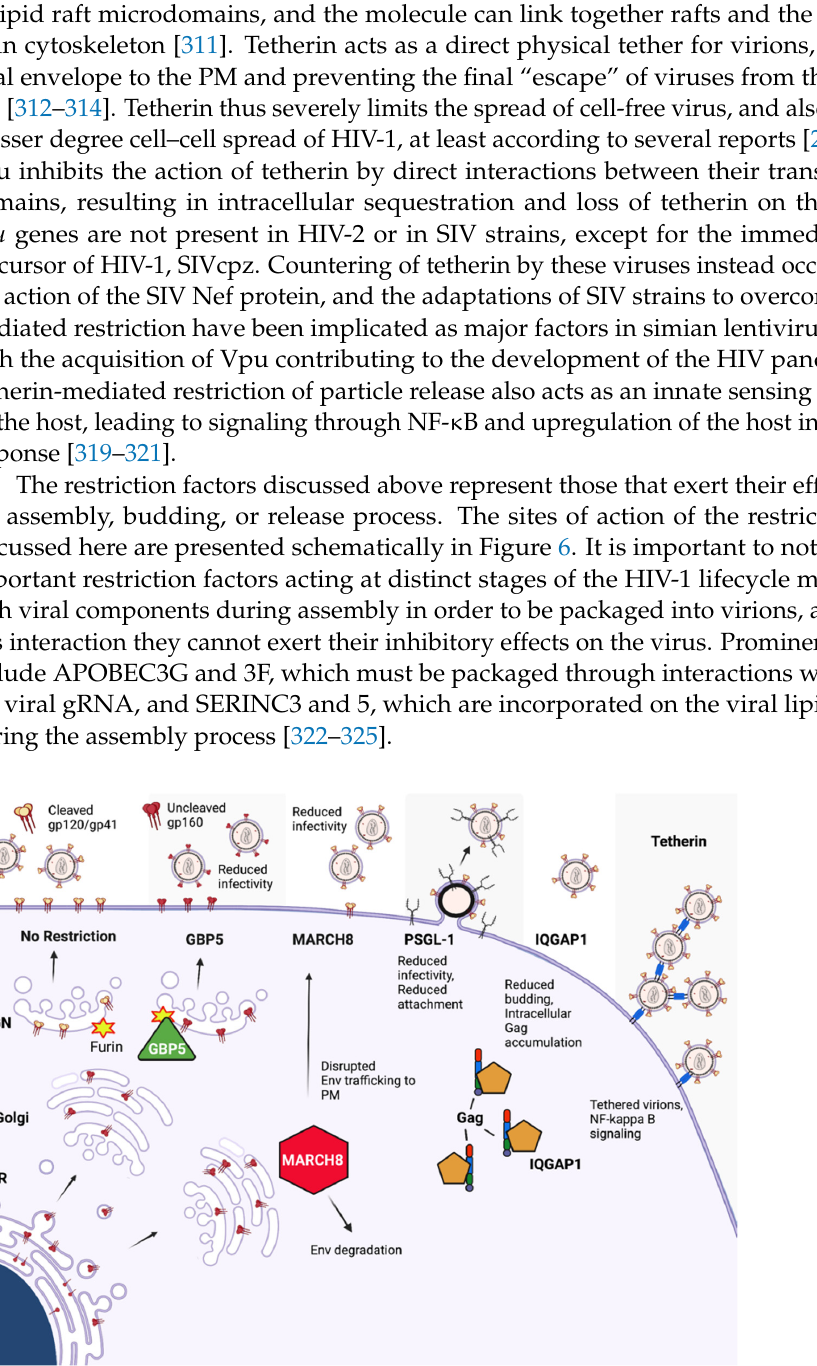
Figure 6. Restriction factors acting along the HIV-1 assembly pathway. On the left is pictured the unrestricted assembly of particles with fully cleaved Env. GBP5 and MARCH8 act to reduce particle infectivity through effects on Env, with a reduction in furin-mediated cleavage (GBP5) or disruption of Env trafficking and incorporation (MARCH8). PSGL-1 reduces Env incorporation but also reduces attachment to target cells. IQGAP1 binds to Gag and modulates particle formation, with reduced production of particles upon overexpression. Tetherin acts to prevent the release of fully formed particles, forming a physical tether to the PM and also acting as an innate immune sensor to stimulate signaling leading to NF- κ B